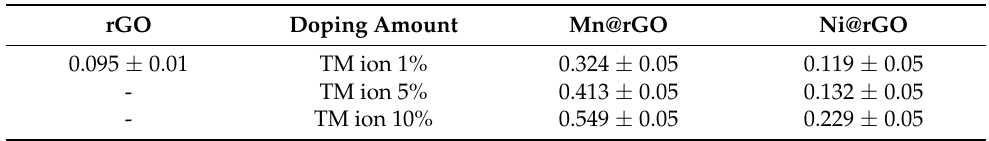
Figure 2. S 2 p core ‐ level spectra as determined based on catalytic oxidation of TP (360 L) in presence of ( a ) Mn@rGO and ( b ) Ni@rGO for different TM ion concentrations resulting from 360 L (1 L = 1 × 10 − 6 torr/s) exposure of TP. Table 1. Catalytic activities of three rGO samples determined based on S2/S1 area ratios from S 2p core ‐ level spectra after oxidation of TP (S2/S1).